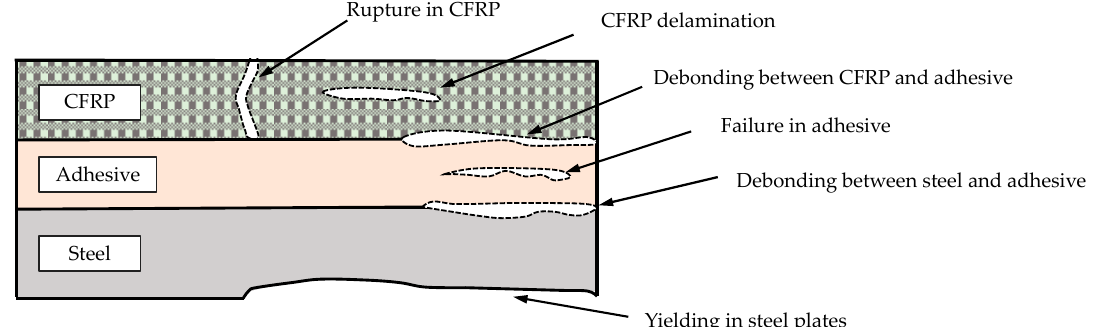
Figure 12. Different types of failure mechanisms in steel/CFRP bonded joint.